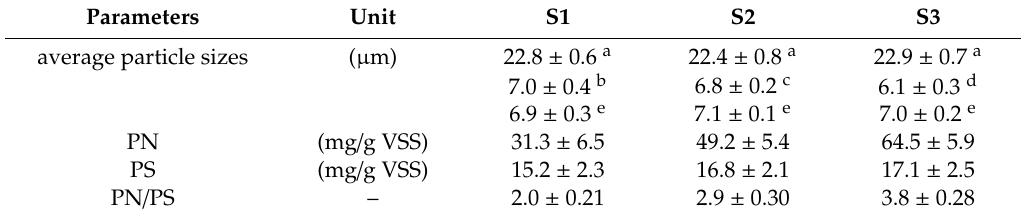
Table 2. The sludge characteristics of the AnMBR at di ff erent sludge cycle frequencies (mean ± standard deviation).